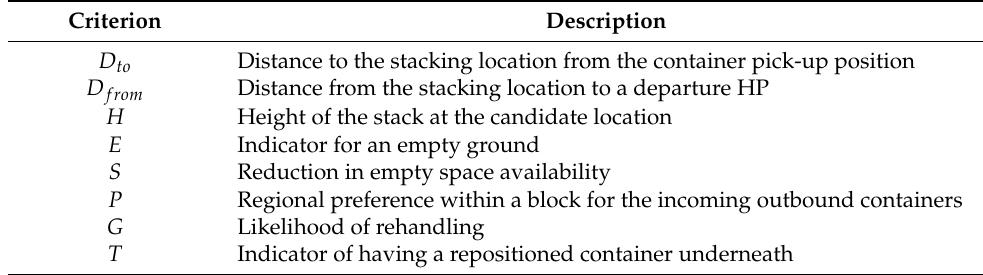
Table 3. Evaluation criteria used in the scoring